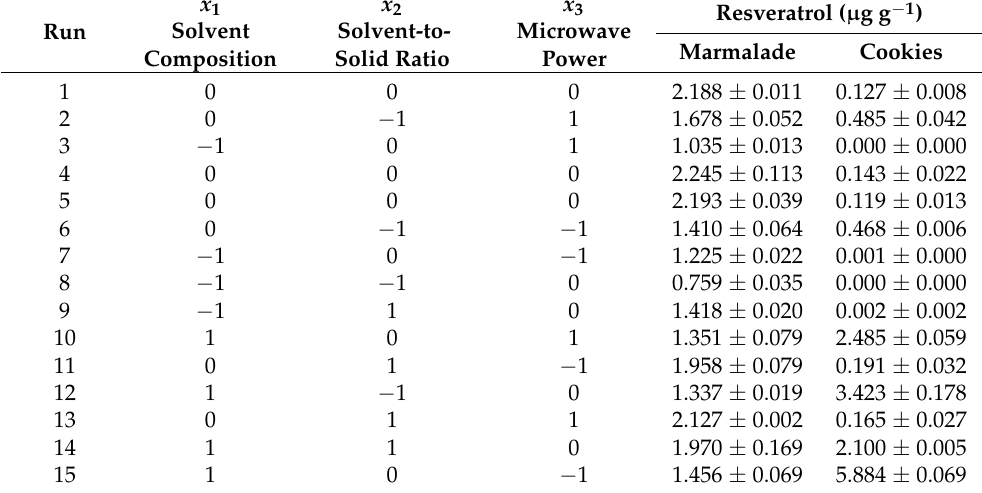
Table 3. Experimental factors of Box–Behnken design and the observed level of resveratrol extracted from marmalade and cookies (mean ± SD) by